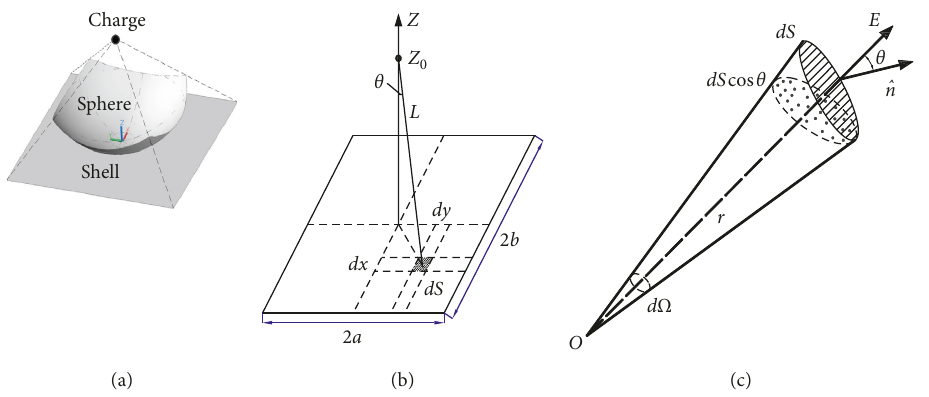
Figure 1: Solid angle calculation diagram of a rectangular plate.